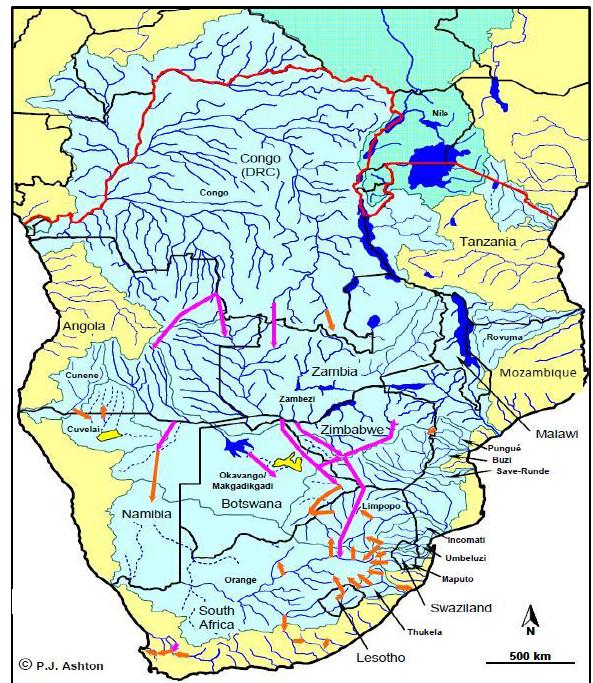
Figure 4. Current and planned inter-basin transfers in southern Africa. Note: Orange lines indicate current transfers; purple lines indicate planned transfers. Source: [9].